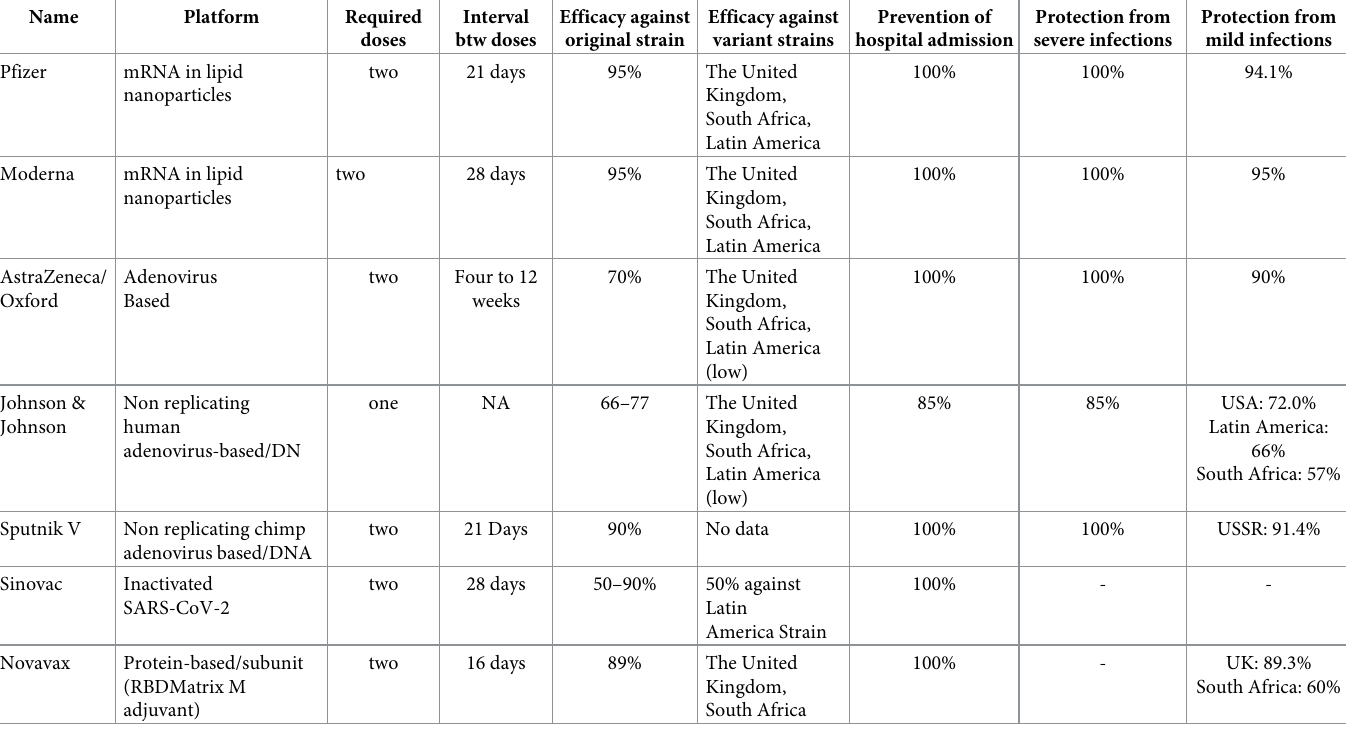
Table 1. Common COIVD-19 vaccines